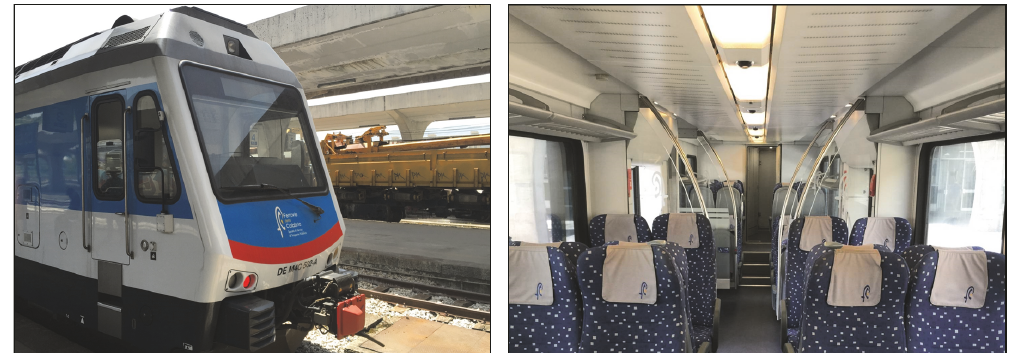
Figure 9: DE M4c.500 STADLER Railcar.